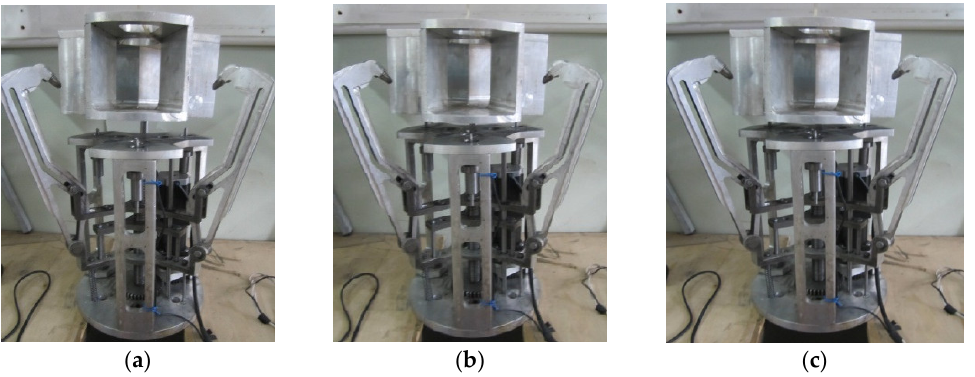
Figure 12. Vertical docking test ( a ) test with offset of 40 mm; ( b ) test with offset of 30 mm; ( c ) test with offset of 20 mm.